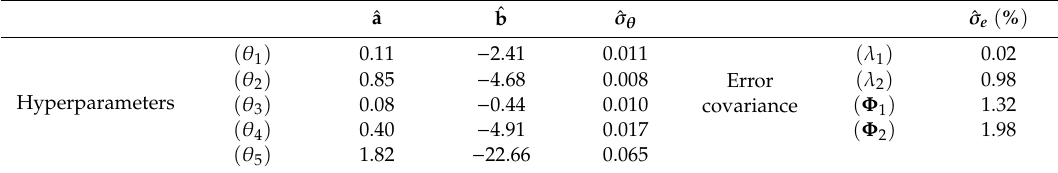
Table 3. MAP values of hyperparameters and error covariance using simplified approach.